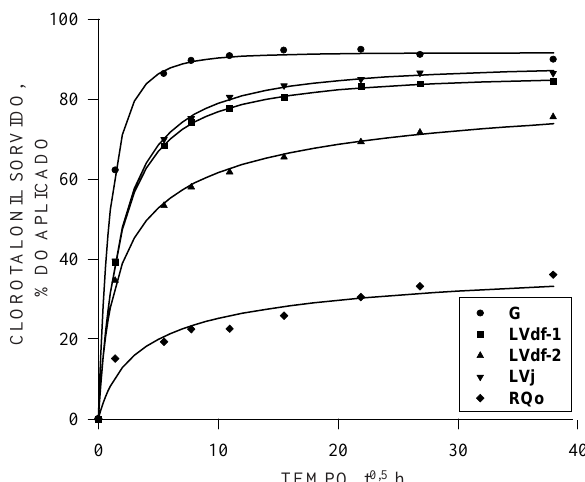
0 Figura 3. Quantidade de clorotalonil sorvido em função da raiz quadrada do tempo para o Neossolo Quartzarênico órtico (RQo), Latossolo Vermelho distroférrico (LVdf-1 e LVdf-2), Latos- solo Vermelho perférrico (LVj) e Gleissolo (G).